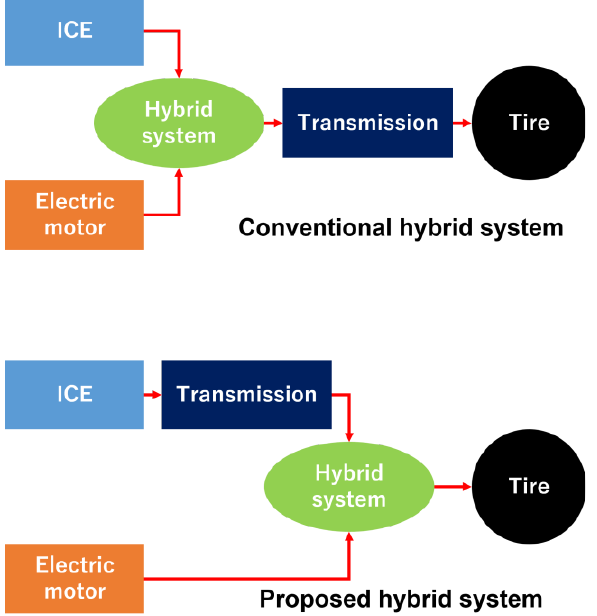
Figure 1. Schematic of the conventional and proposed hybrid systems.